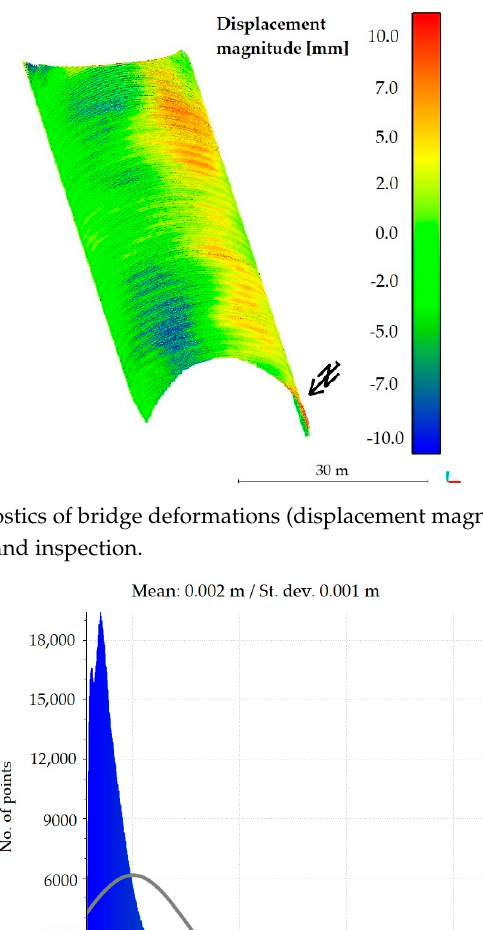
Figure 16. Periodic diagnostics of bridge deformations (displacement magnitude) measured one year after the final acceptance and inspection.